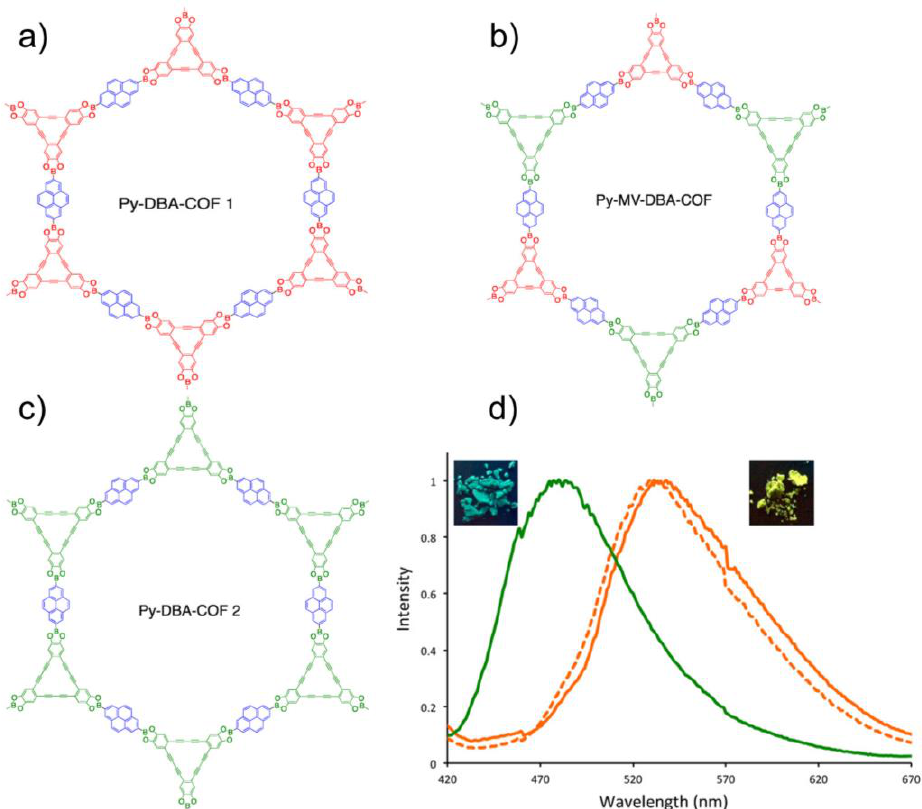
Figure 6. The chemical structure of ( a ) Py-DBA-COF 1, ( b ) Py-MV-DBA-COF, and ( c ) Py-DBA-COF 2. ( d ) Normalized emission spectra and photographs of Py-DBACOF 1 (orange line), Py-DBA-COF 2 (green line), and Py-MV-DBA-COF (orange dashed line), respectively. Reproduced with permission from Ref. [63]. Copyright 2016, American Chemical Society.